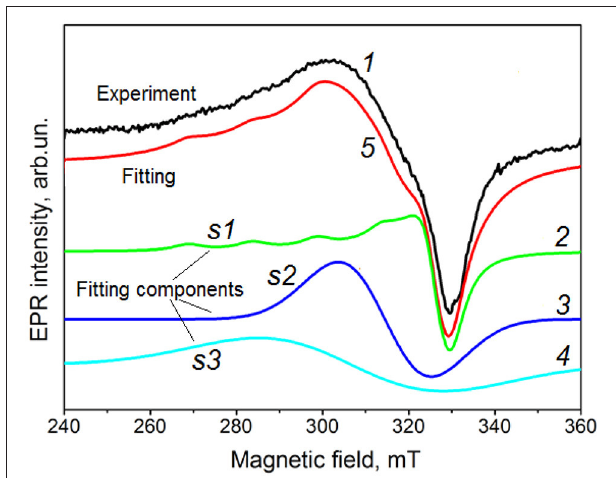
FIGURE 7 | EPR spectrum of the Cu-8 sample calcined at 600 ◦ C (1) and its decomposition on three components s1 (2), s2 (3), and s3 (4). Curve 5 represents the result of the fitting of total EPR spectrum. This curve is shifted for clarity. The experimental EPR spectrum is spectrum I type as described in the